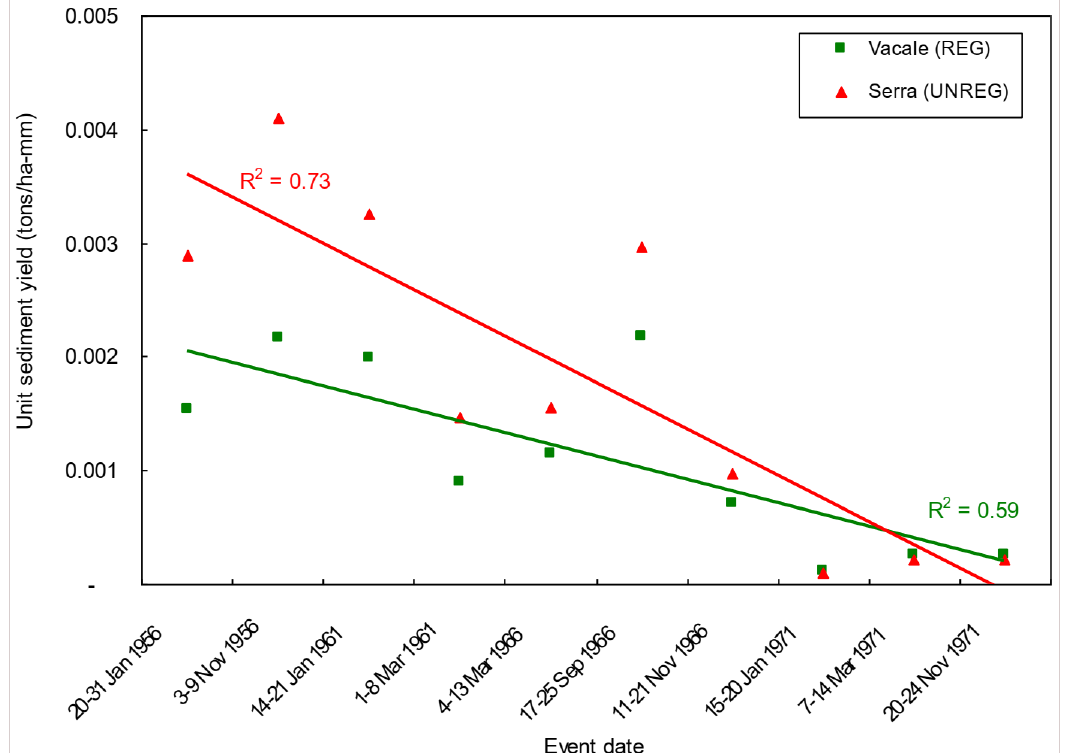
Figure 10. Temporal evolution of unit sediment yield (per unit precipitation) in unregulated (UNREG) and regulated (REG) sub-catchments (Calabria, Southern